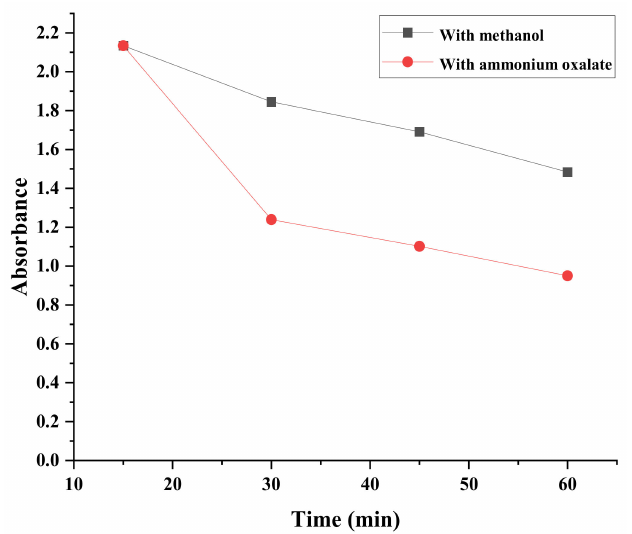
Figure 22. The effect of different radical scavengers on catalytic degradation of Eosin Y by arbutin- mediated